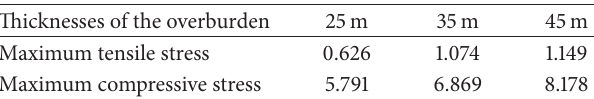
Table 4: Maximum principal stress under different thicknesses of the overburden (MPa).